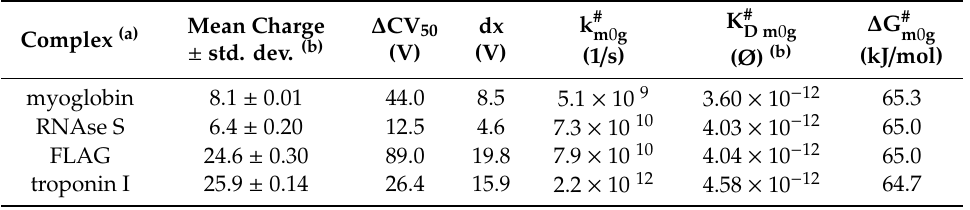
Figure 4. Nano-ESI mass spectra from myoglobin dissociation experiments. Different collision cell voltage differences ( ∆𝐂𝐕 ) are shown. ( A ) 4 V. ( B ) 30 V. ( C ) 60 V. ( D ) 120 V. Charge states and m/z values for selected ion signals are given for holo-myoglobin ions (red circles with dots on right ion series), apo-myoglobin ions (blue circles without dots on right ion series) and for the released heme ions (green dots on left ion series). Solvent: 200 mM ammonium acetate, pH 7. Table 1. Apparent kinetic and apparent quasi-thermodynamic values for gas phase dissociation of Mean charge states of holo-myoglobin ions (m+), apo-myoglobin (n+) and heme (p+) as well as non-covalent apex heights (holo-myoglobin ions (h, educts), heme ions (i, product), and apo-myoglobin ions (j,